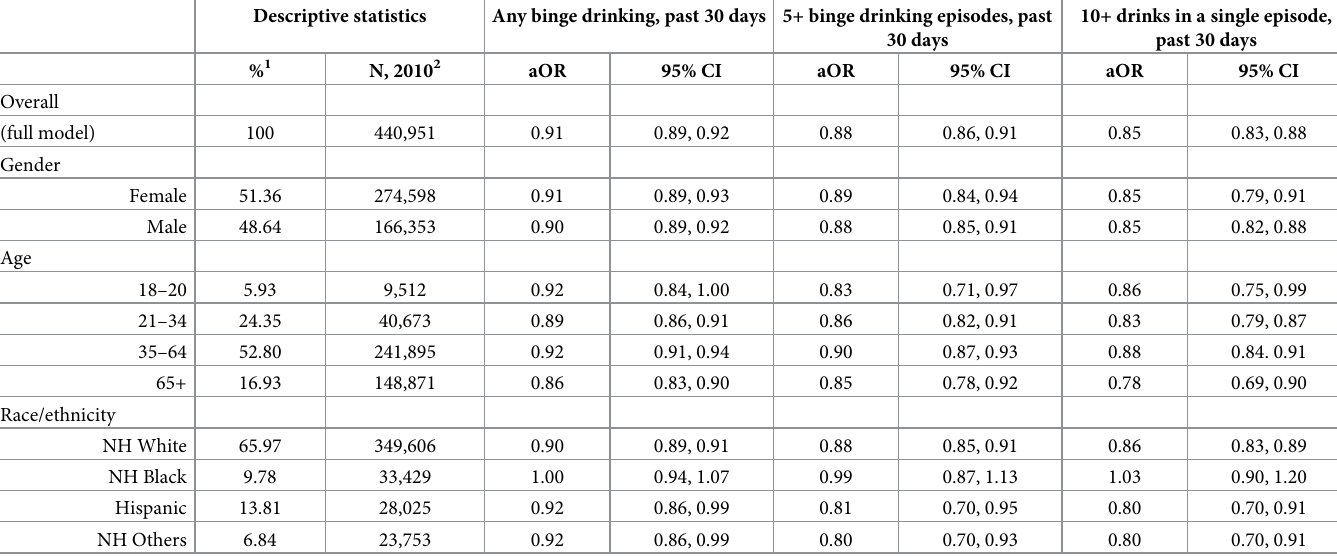
Table 4. Adjusted odds ratios of high-risk drinking with a 10-percentage point increase in 1-year lagged SAPS, 2005–2010. Descriptive